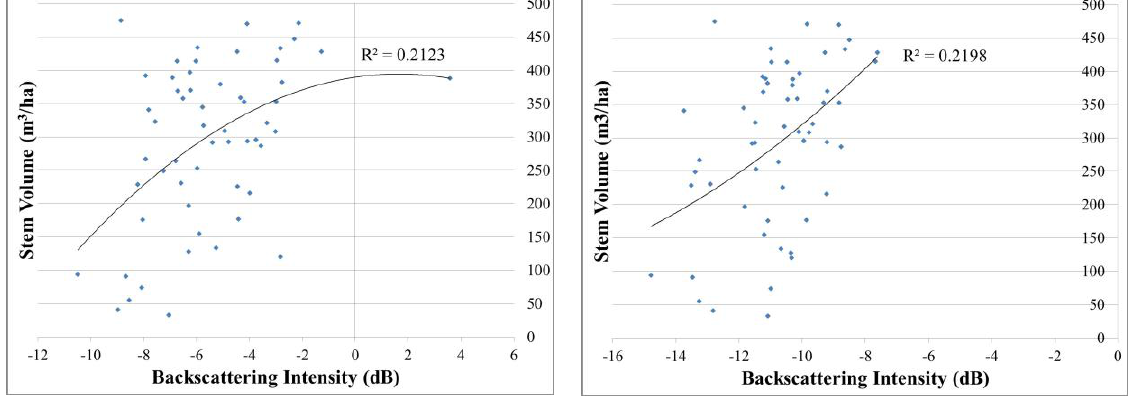
Figure 3. Relationship between Stem Volume (m 3 /ha) and backscattering for HH ( left ) and HV ( right ) polarization at mean 25 m pixel spacing data from 2009 and 2010 (HH: R 2 = 0.2123, HV: R 2 =